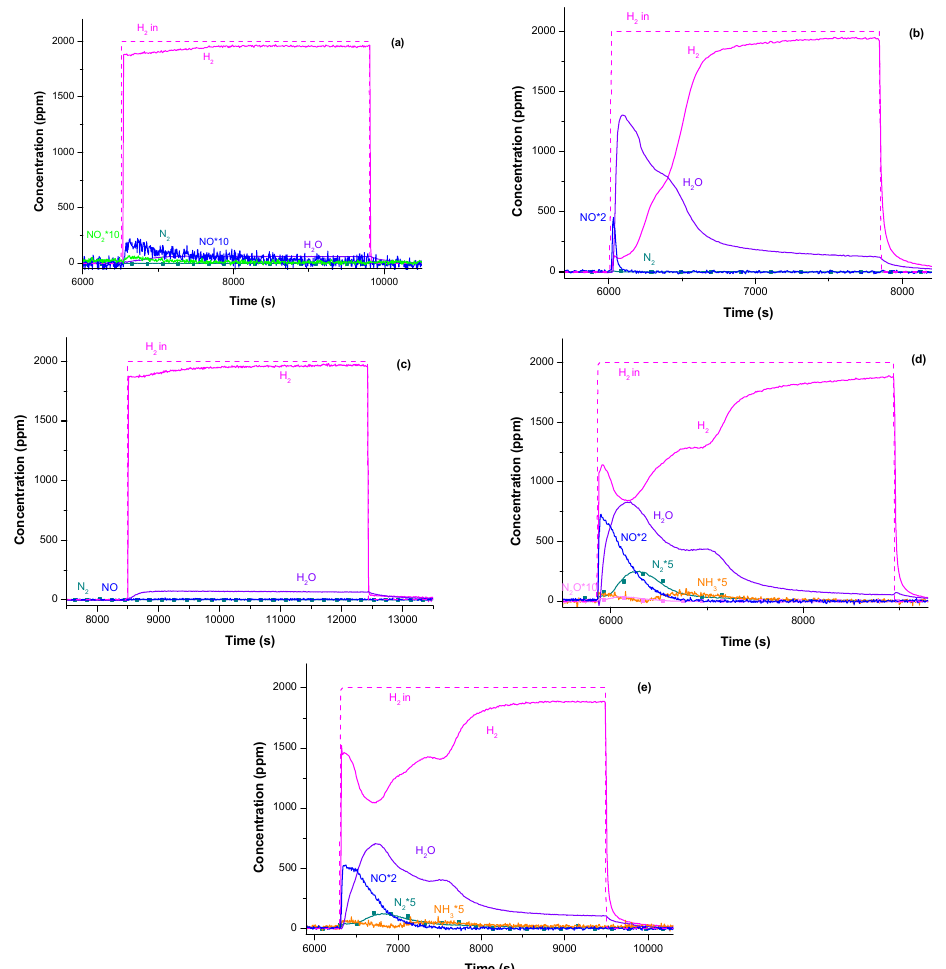
Figure 3. H 2 , N 2 , NH 3 , NO, NO 2 , and H 2 O outlet concentrations, and H 2 inlet profile (in dotted lines) of the reduction step under 2000 ppm H 2 , at 300 °C, for the catalysts: ( a ) CZ; ( b ) Cu2/CZ; ( c ) Ba6/CZ; ( d ) Ba6/Cu2CZ; and ( e ) Ba11/Cu2CZ. Different features are observed when Cu is present in the catalyst formulation (i.e., in the case of the Cu2CZ and BaX/Cu2CZ catalysts, X = 6, 11 wt %). Indeed, in these cases (Figure 3b–e), a huge amount of water is produced upon H 2 admission, which generates a high population of oxygen vacancies, in line with the extension of the reduction of these catalysts in the range of 150–300 °C, as observed during the H 2 -TPR experiments [48]. Considering the Cu2/CZ catalyst (Figure 3b), as soon as H 2 is admitted to the reactor, a very small and fast NO release is observed; the N-balance reveals that the very low amount of adsorbed NO x (8.9 µmol/g cat ) is completely removed from the surface (see Table S1). The NO x reduction is not selective to nitrogen, and only NO is detected during the